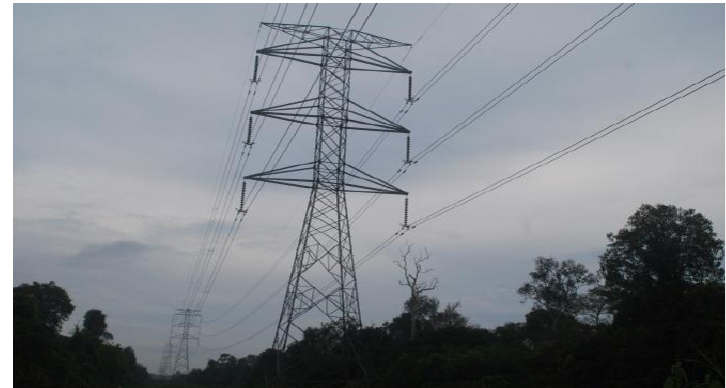
Figure 8. Fibre cross ‐ arms on steel tower [49].